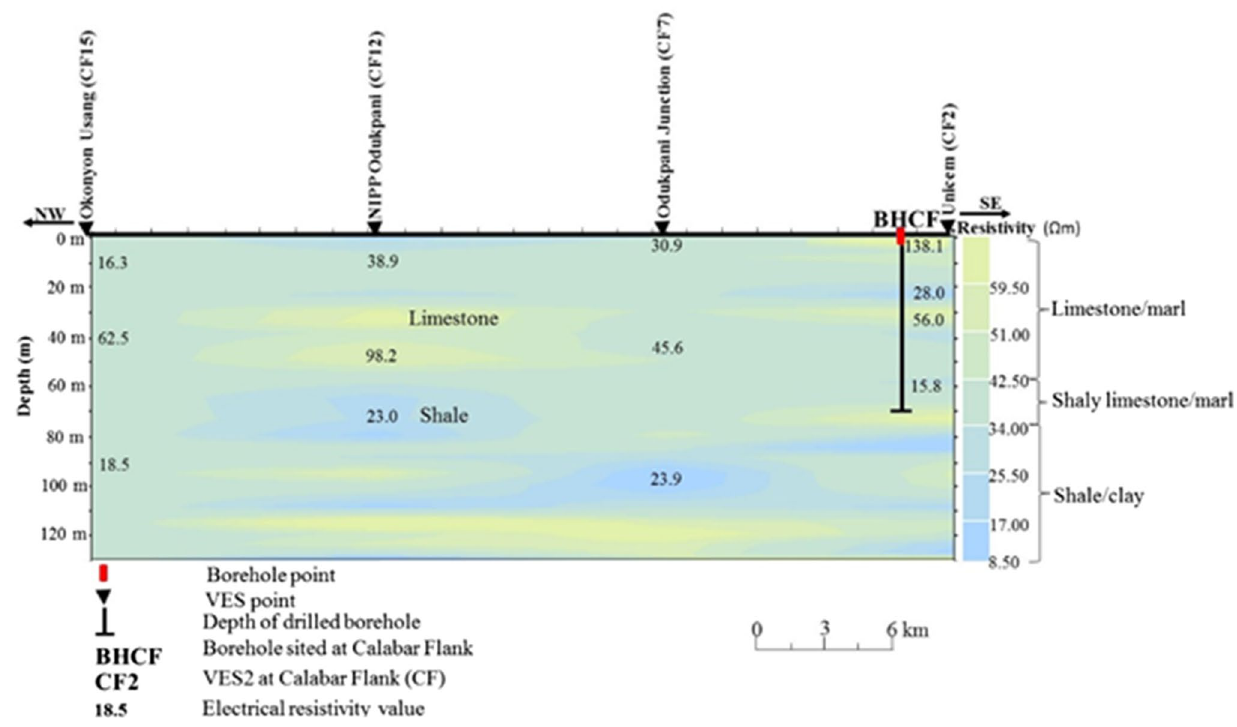
Fig. 7 Electro-stratigraphic section oriented NW–SE in the